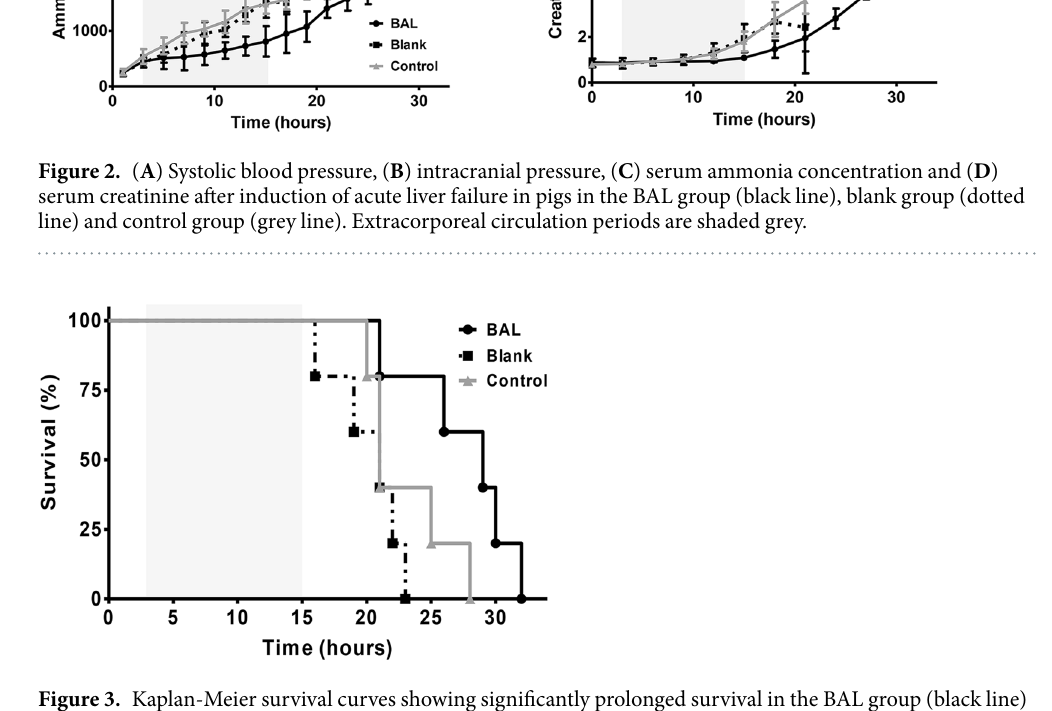
Figure 3. Kaplan-Meier survival curves showing significantly prolonged survival in the BAL group (black line) compared to the blank group (dotted line, P = 0.03). There was no significant difference in survival between the control group (grey line) and BAL group (P = 0.44). The 12-hour treatment period is shaded